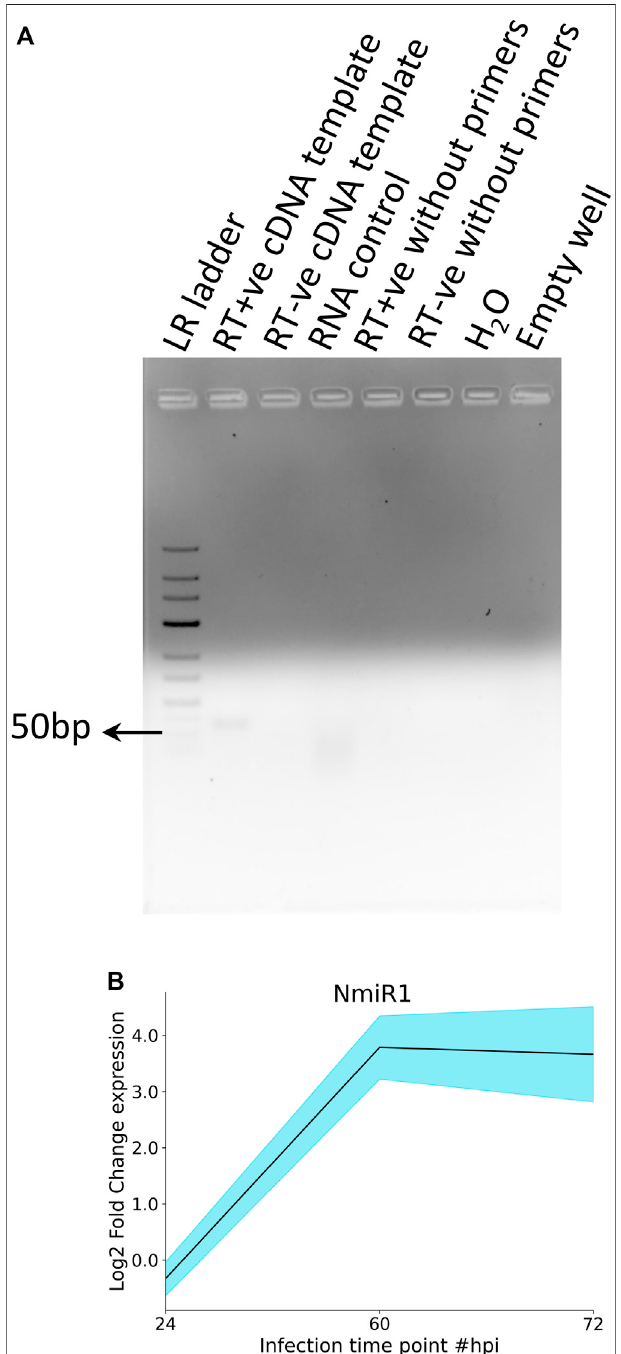
FIGURE 7 | RT-PCR and qRT-PCR analysis of NmiR1. (A) In order to con fi rm the novel miRNA prediction, speci fi c primers were designed for putative novel miRNA (NmiR1) and subjected to RT-PCR to visualize the expected amplicon (50 bp), whereas negative controls (RNA, H 2 O) did not yield any product. (B) qRT-PCR differential expression analysis shows the upregulation of NmiR1 at 60 hpi and 72 hpi of R. solani inoculation with respect to control